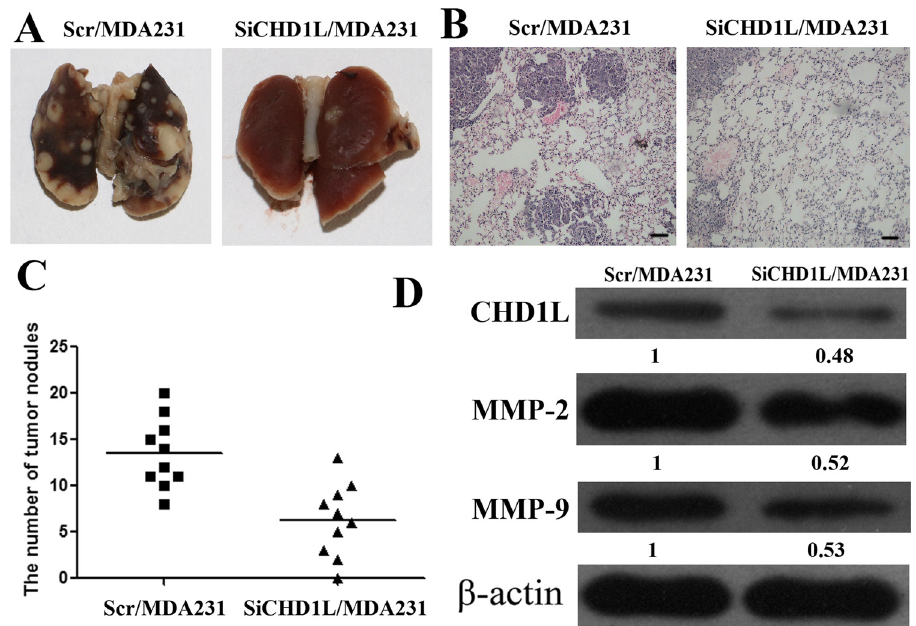
Fig 4. CHD1L promotes lung colonization of human breast cancer in vivo . (A) Comparison of tumor cell colonies in mouse lungs between groups. (B) Tumor foci in mouse lungs were visualized using H&E staining. Scale bar: 50 μ m. (C) Lung metastatic nodules were counted ( n = 10). (D) Expression of CHD1L, MMP-2, and MMP-9 was detected in mice xenograft tumors by Western blot analysis. β -Actin was used as a loading control. Quantification of relative protein levels on three different Western blot analyses is shown below the blots.